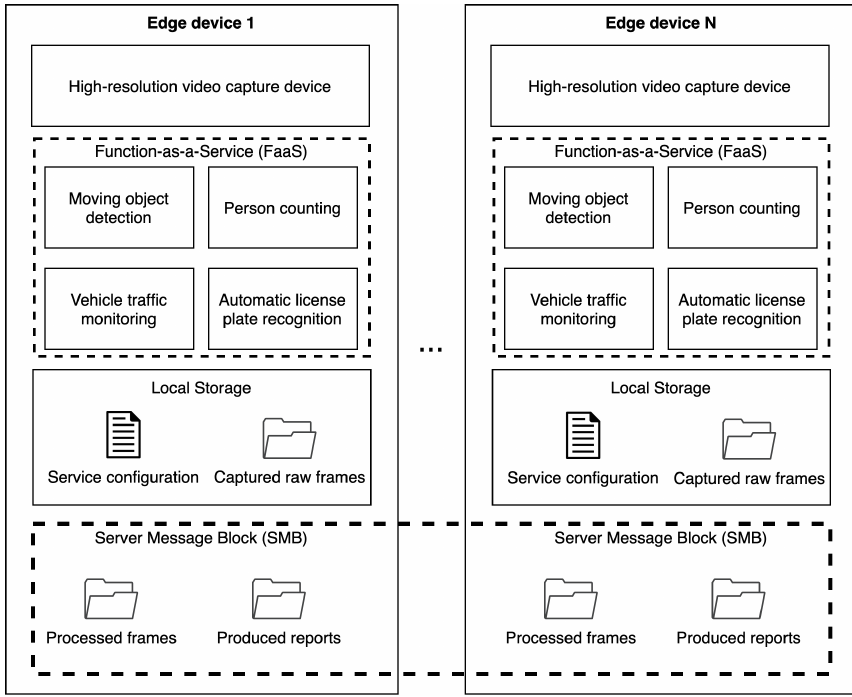
Figure 1. Architecture diagram service provisioning on Virtual Device